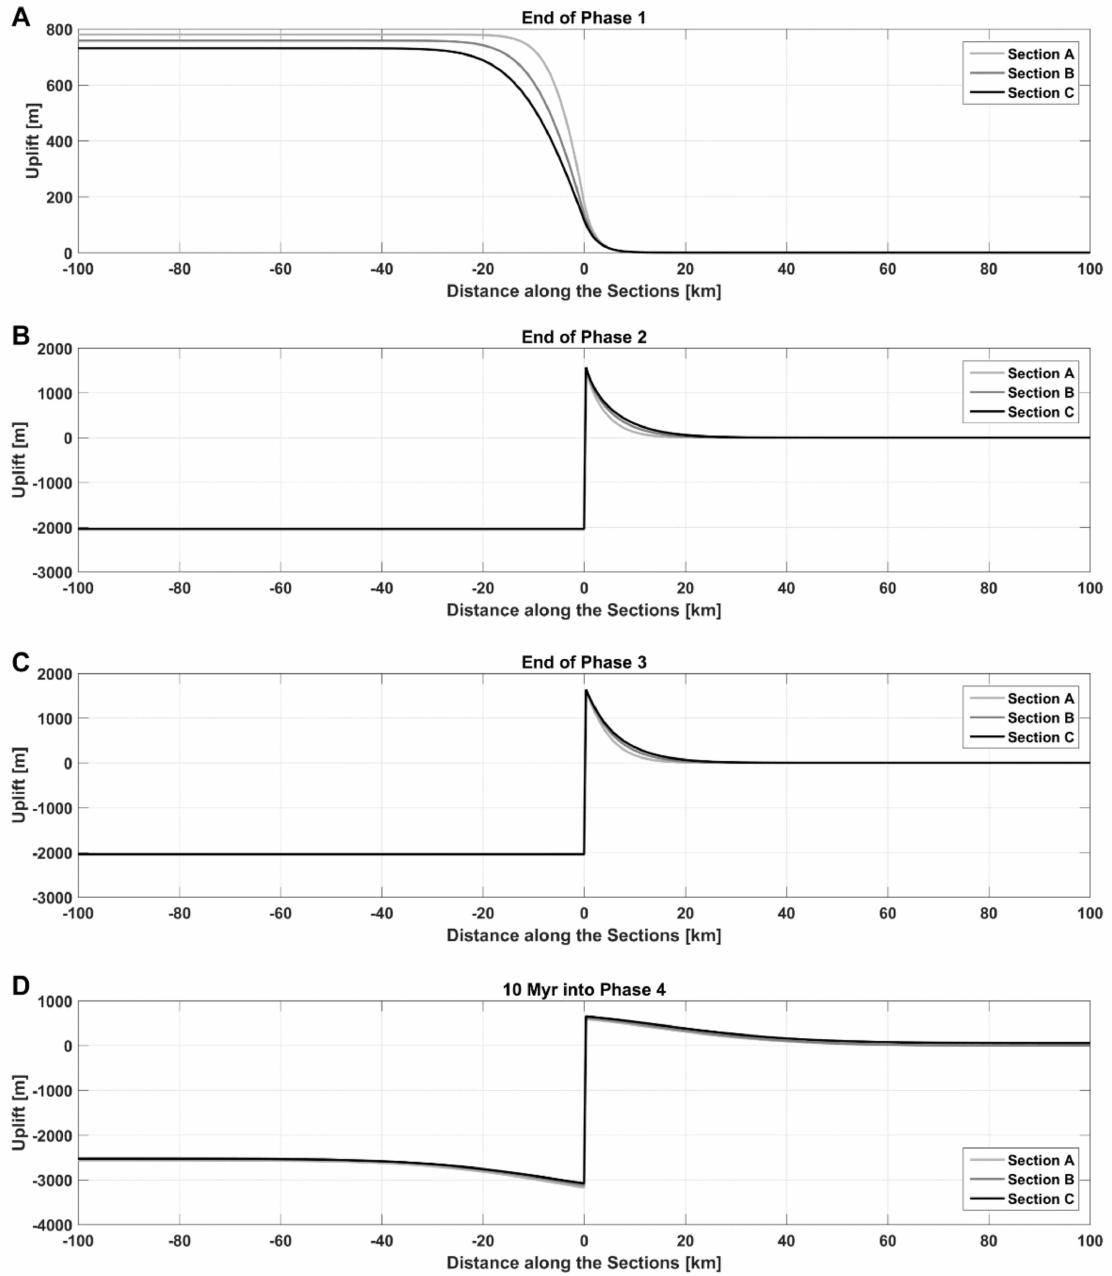
Figure 10. Uplift generated in the lithosphere along sections A, B, and C at the end of various phases along the transform margin for an intermediate spreading system. Sub-figures A to D denote transform phases 1 to 4 (see